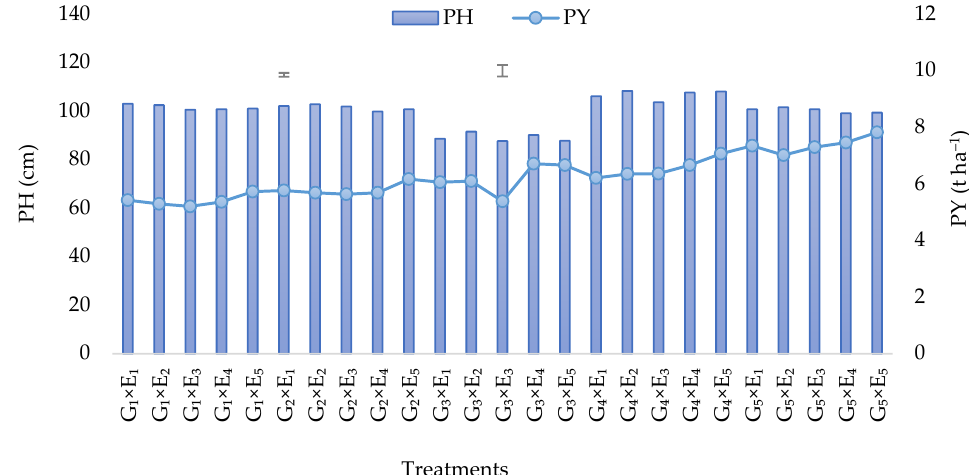
Figure 4. G × E interaction on the plant height (PH) and paddy yield (PY) of rice varieties.